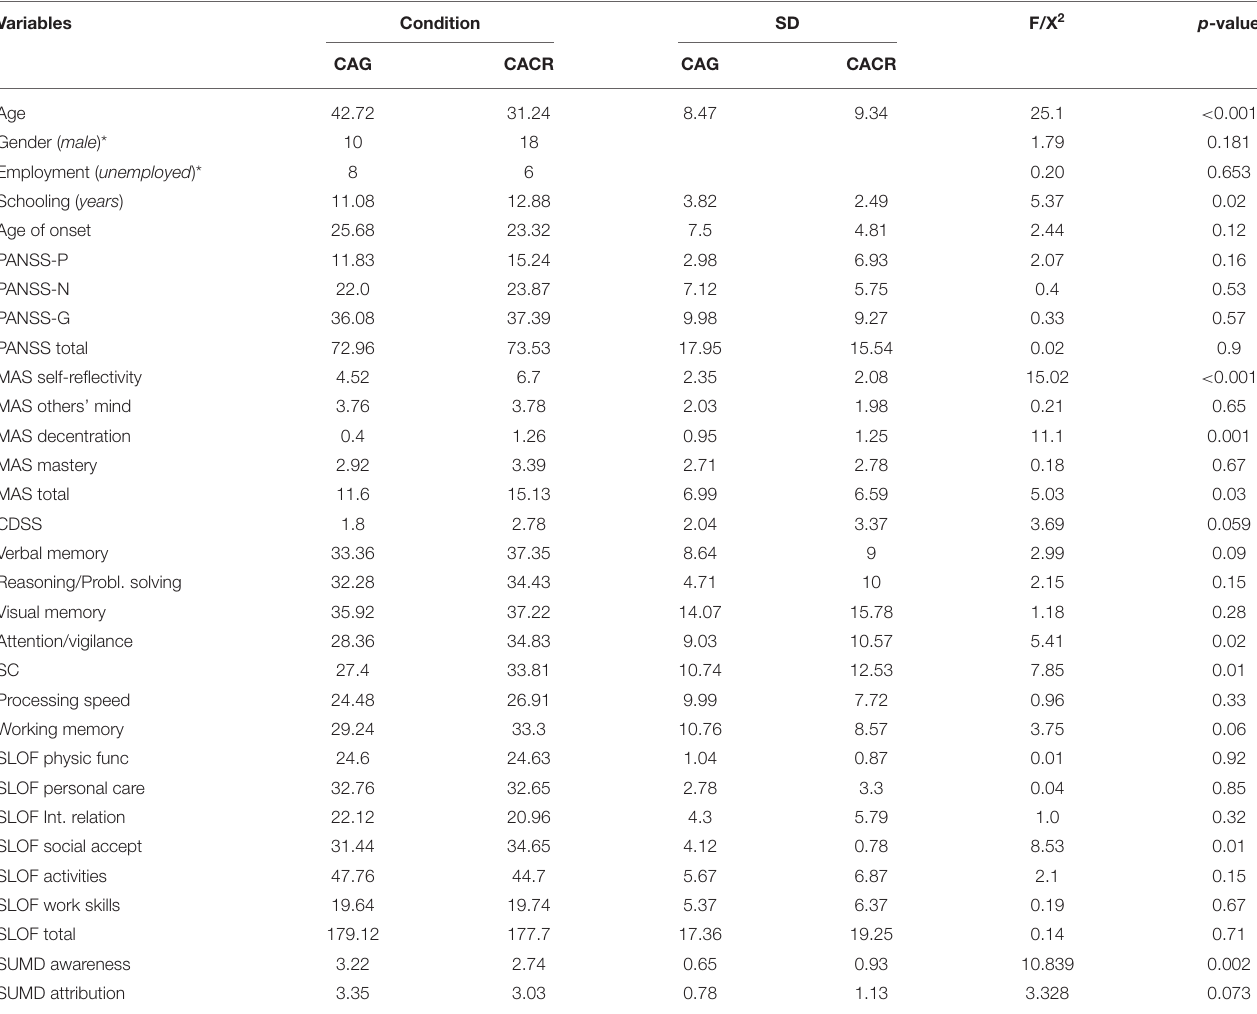
TABLE 3 | Demographical, clinical, neuropsychological, metacognitive and functioning characteristics of the sample. Variables Condition SD F/X 2 p -value CAG CACR CAG